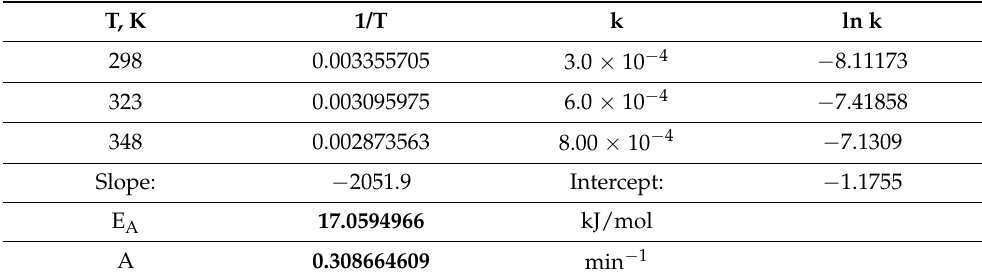
Figure A2. Arrhenius chart for WA compacts. Table A3. * Reaction parameters for WA compacts.